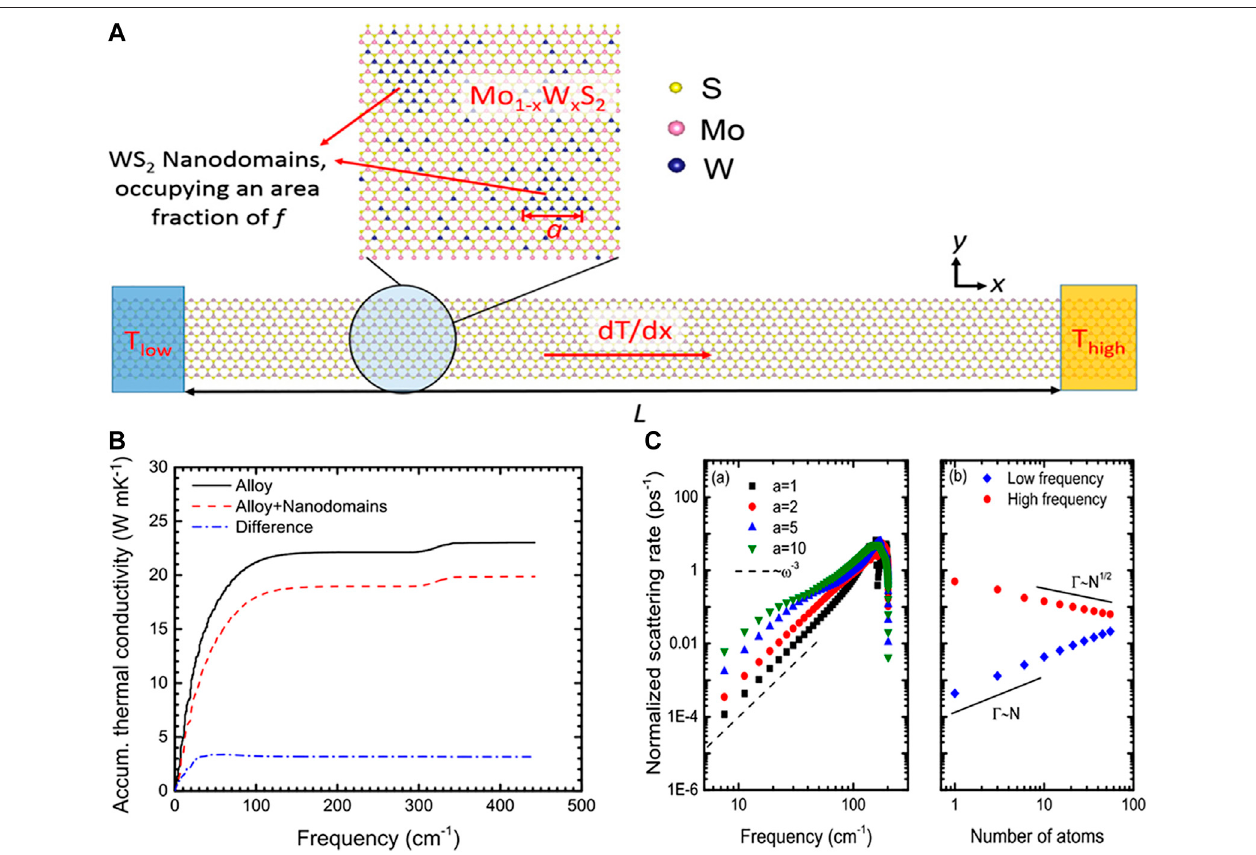
FIGURE 6 | A typical atomic con fi guration for the Mo 1 − x W x S 2 alloy embedded with triangular WS 2 nanodomains (B) The accumulative thermal conductivity of Mo 0.5 W 0.5 S 2 withandwithoutnanodomainsembeddedasafunctionphononfrequency. (C) ThephononnanodomainscatteringratesofLAphononsfromthe Γ pointto the M point and the phonon nanodomain scattering rates of long-wavelength LA phonons and short-wavelength LA phonons. Reproduced from (Gu and Yang, 2016) with permission from American Physical